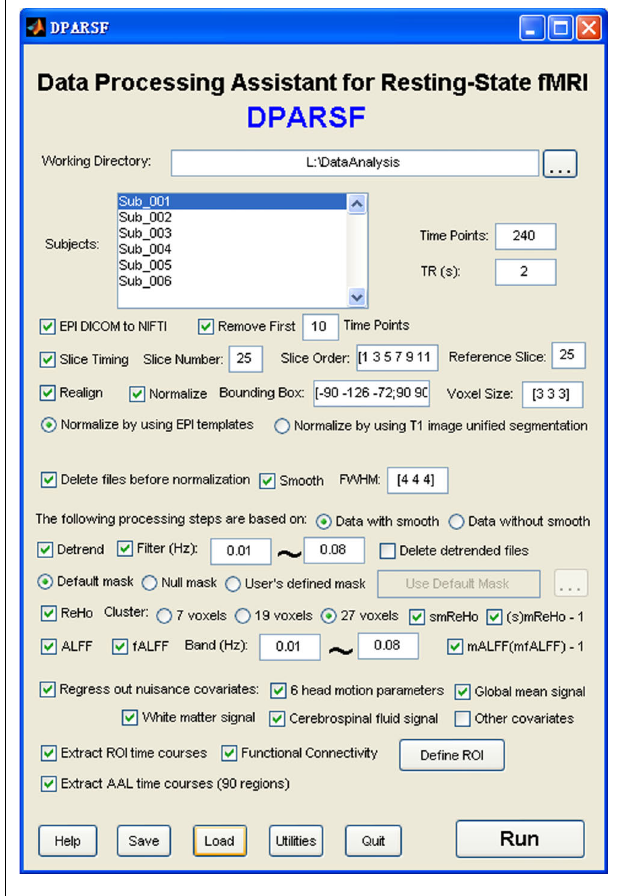
FIGURE 1 | Graphical user interface of